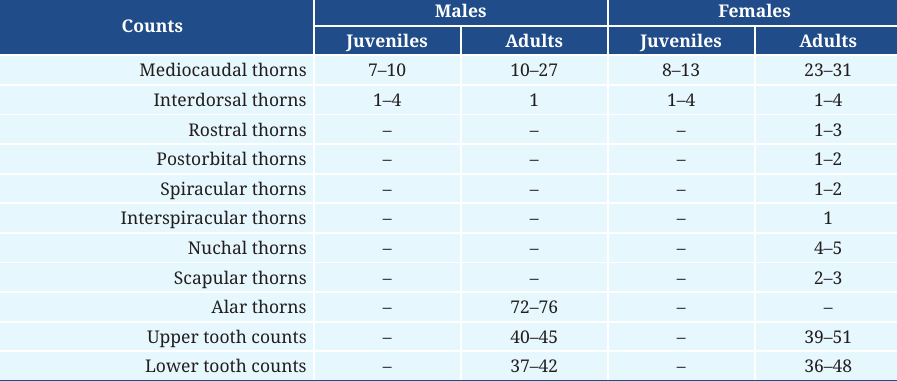
TABLE 2 | Meristic counts of males and females, juveniles and adult specimens of Rioraja agassizii